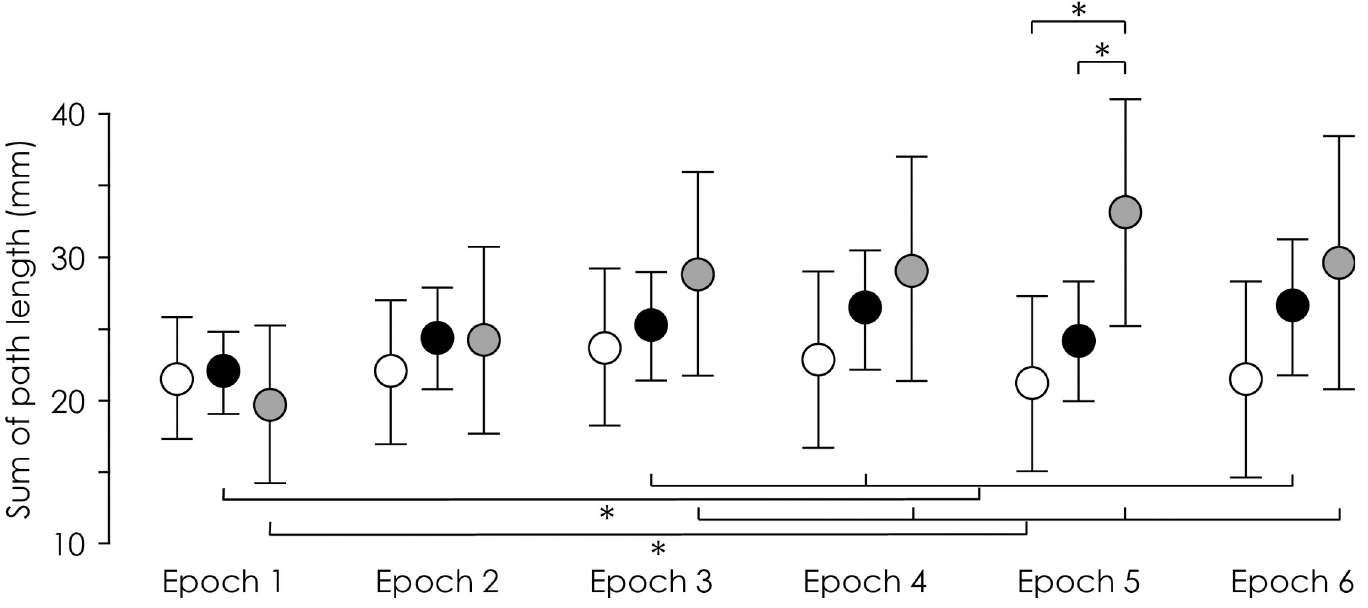
Fig 5. Group data for movement variability, quantified as with sum of path length during averaged across blocks. Group mean and 95% CI of sum of path length of 10-repetition epochs for the Control (white), Pain 5–1 (black), and Pain 5–0 (grey) groups. � —p < 0.05 between bracketed items.